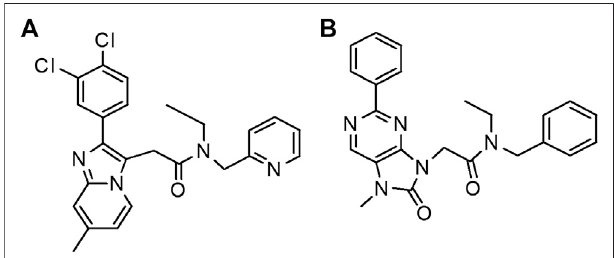
FIGURE 1 | Chemical structural of YL-IPA08 (A) and AC-5216 (IS) (B)